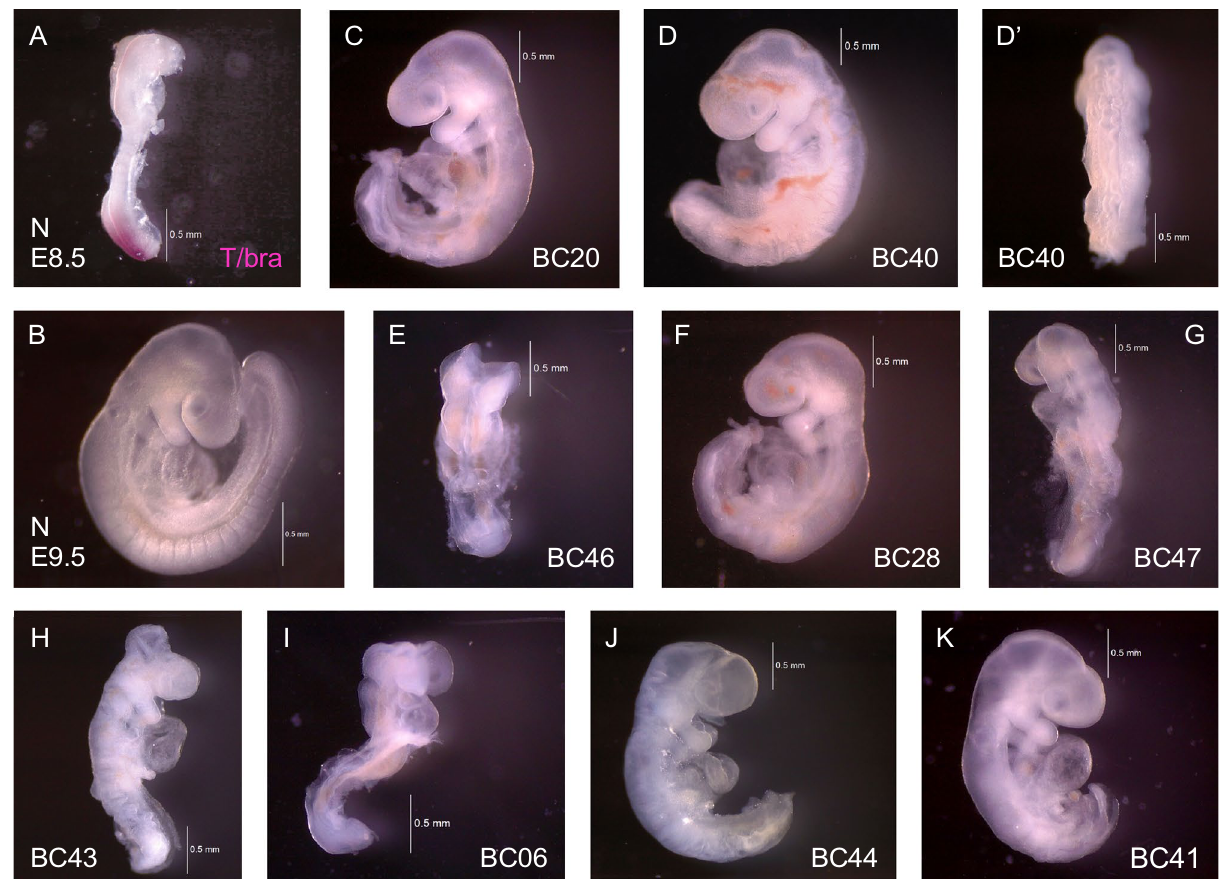
Figure 3. Morphological abnormalities of individual CRISPants. Panels A and B show normal mouse embryos at E8.5 ( A ) and E9.5 ( B ). Based upon the earlier expression of T/brachyury in the primitive streak, notochord, and the posterior region (as shown by in in situ hybridization in ( A ), disruption of the coding region by targeting the third exon for CRISPR editing is expected to cause morphological abnormalities in somite formation, neural tube morphogenesis and reduced growth of the posterior. Panel B shows a normal mouse embryo with well-formed somite boundaries, and long posterior region. CRISPants are designated according to their barcode numbers (see Table 1), and they are ordered in this figure by ascending content of mutant alleles. BC20 and BC40 ( C , D , and D ′ ) carry only the ∆11@-1 ϴ allele, likely in homozygous configuration, and they exhibit disrupted somite formation and an abnormal tail region, accompanied in BC40 by wavy neural tube ( D ′ ). ( E ) BC46 carries the ∆11@-5 ϴ allele, and displays a disordered neural tube, as well as a somite-less and shortened posterior region. ( F ) BC28 contains both ∆11@-1 ϴ and ∆11@-5 ϴ deletions; while the neural tube has closed in the anterior region, somites are not discernable in the trunk and shortened posterior region, which also reveals a wavy neural tube. ( G ) BC47 harbors the longest 2728 bp and both 11 bp deletion alleles; the neural tube is disordered and wavy in the trunk, heart development is compromised and somites are absent in the posterior. ( H ) BC43 carries 3 deletions ranging from 719 to 998 bps, a 10 bp deletion and the one nucleotide insertion alleles; morphogenesis of somites and neural tube is abnormal, with wavy neural tube and shortened tail region. ( I ) BC06 contains 3 deletions over 1000 bps in size, and 691 bp and 100 bp deletion alleles; the entire trunk region is malformed and shorter, somites are absent, and heart development is also abnormal. ( J ) BC44 harbors 6 deletion alleles, and exhibits lack of somites, wavy neural tube from the hindbrain along the entire trunk, and a severely truncated tail region. ( K ) BC41 carries 6 different deletion alleles, and displays complete absence of somites and neural tube below the heart and in the posterior